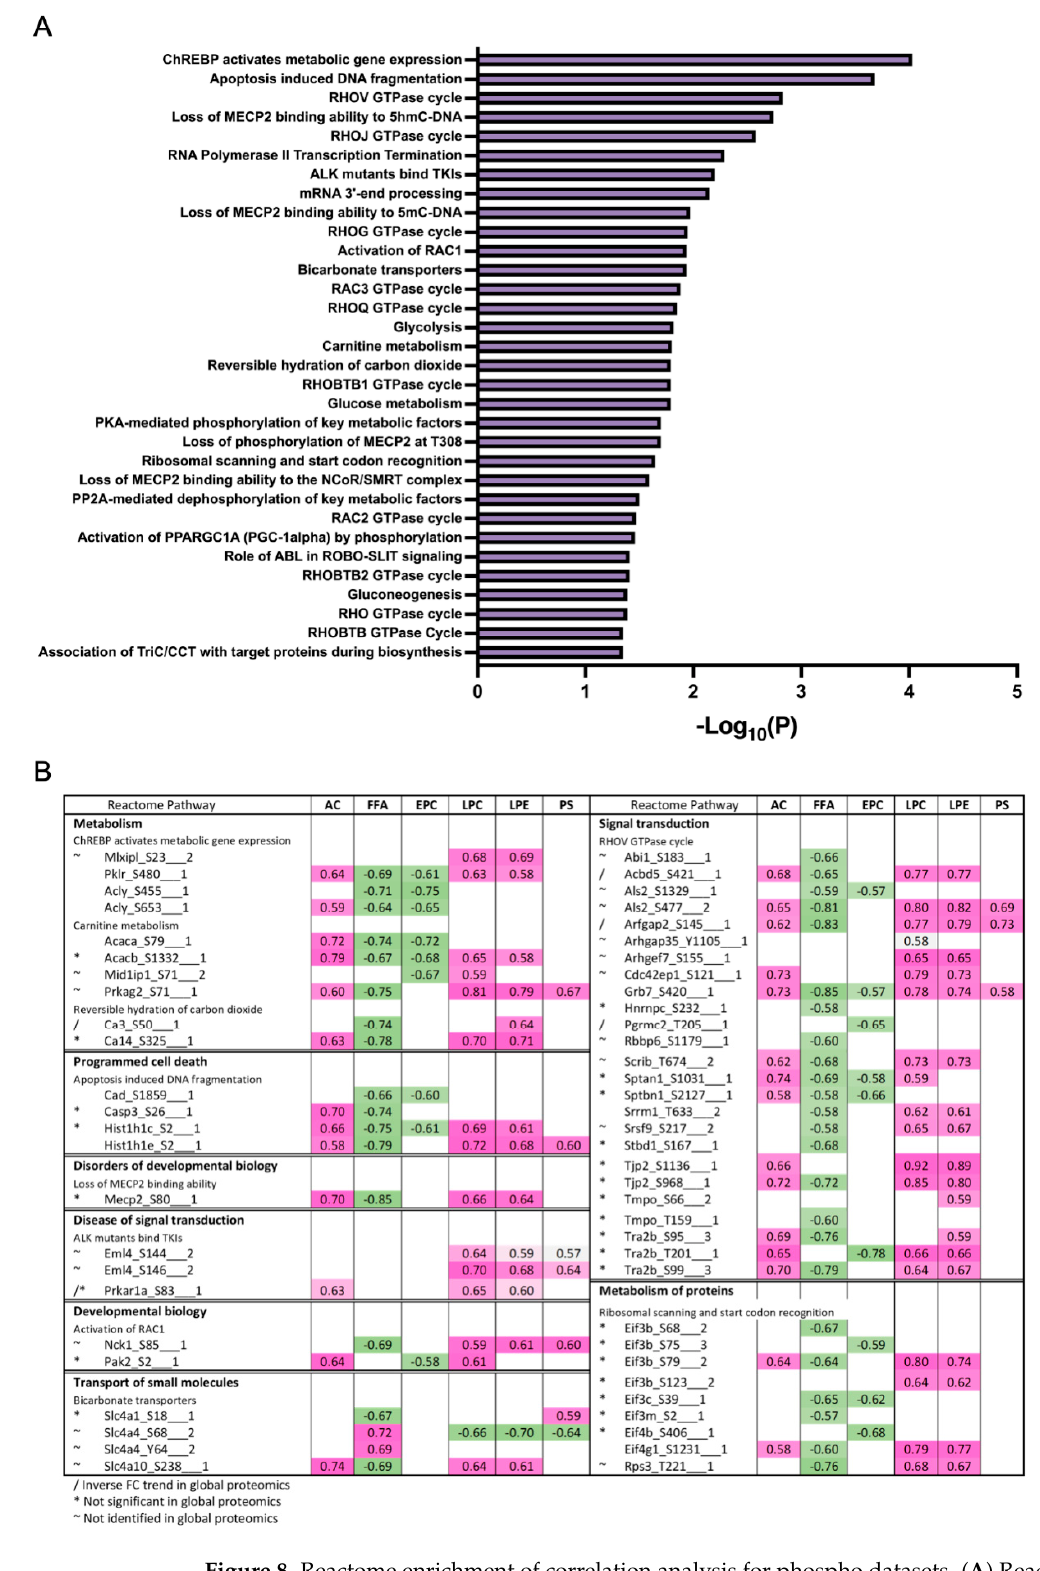
Figure 8. Reactome enrichment of correlation analysis for phospho datasets. ( A ) Reactome enriched pathways from global phosphoproteins significantly correlated with lipids. ( B ) Correlation analysis of phosphosites of interest, categorized by enriched reactome pathway and lipid classes.